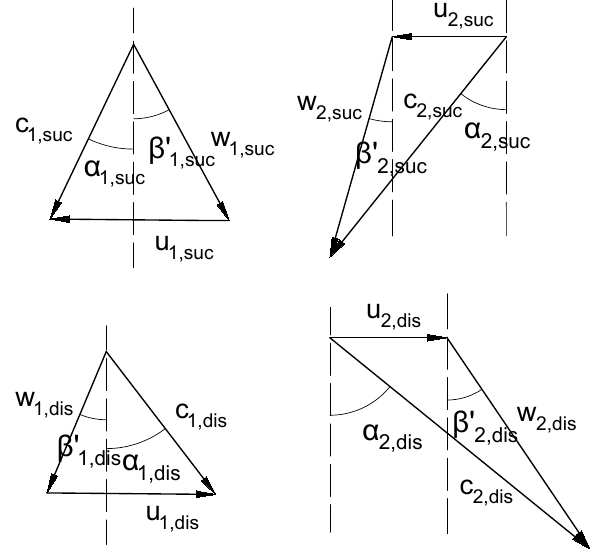
Figure 6. Velocity triangles in the two stages of a cross-flow fan using the streamline